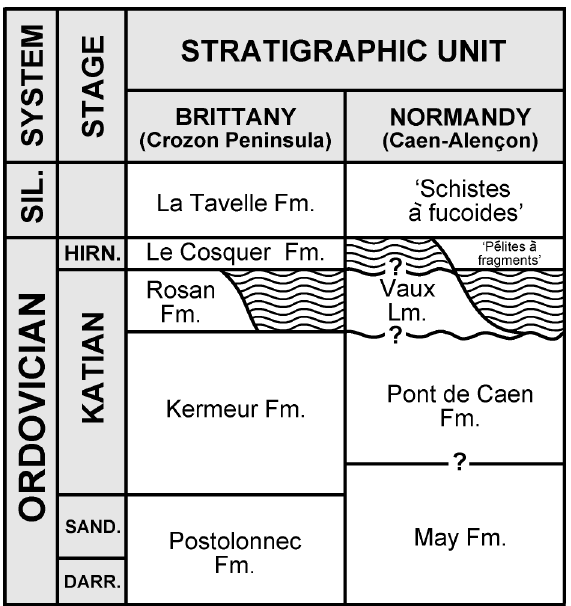
Fig. 2. Summary stratigraphic diagram showing inferred relations between Upper Ordovician units exposed in Brittany (Crozon Peninsula) and Normandy (Caen-Alen(cid:231)on) (mostly after Paris & Le HØrissØ 1992; Avoine et al. 2011; Vidal et al. 2011).